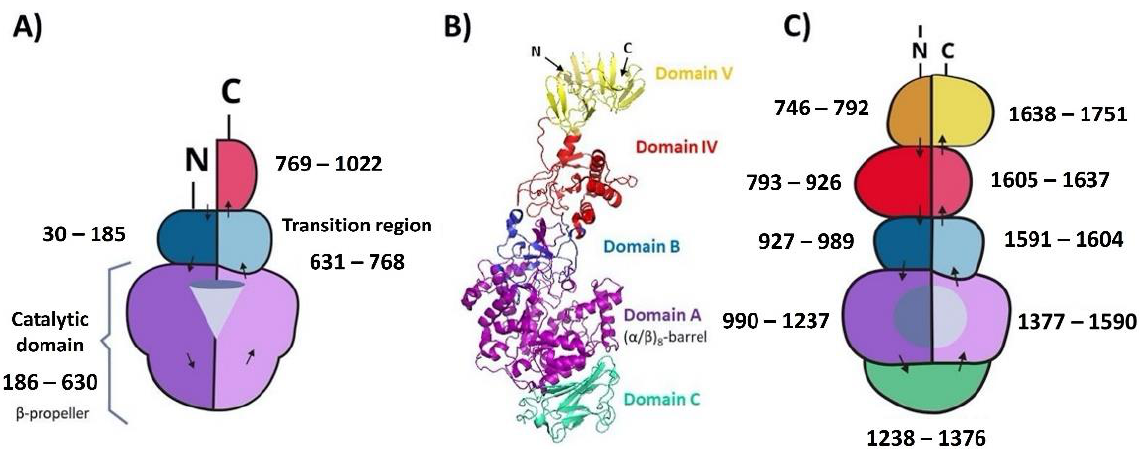
Figure 6. Hypothetical schematic representation of the LevS levansucrase from Leuconostoc mesenteroides. ( A ) LevS could have a U-shaped folding similar to that of glucansucrases. ( B ) Crystal structure